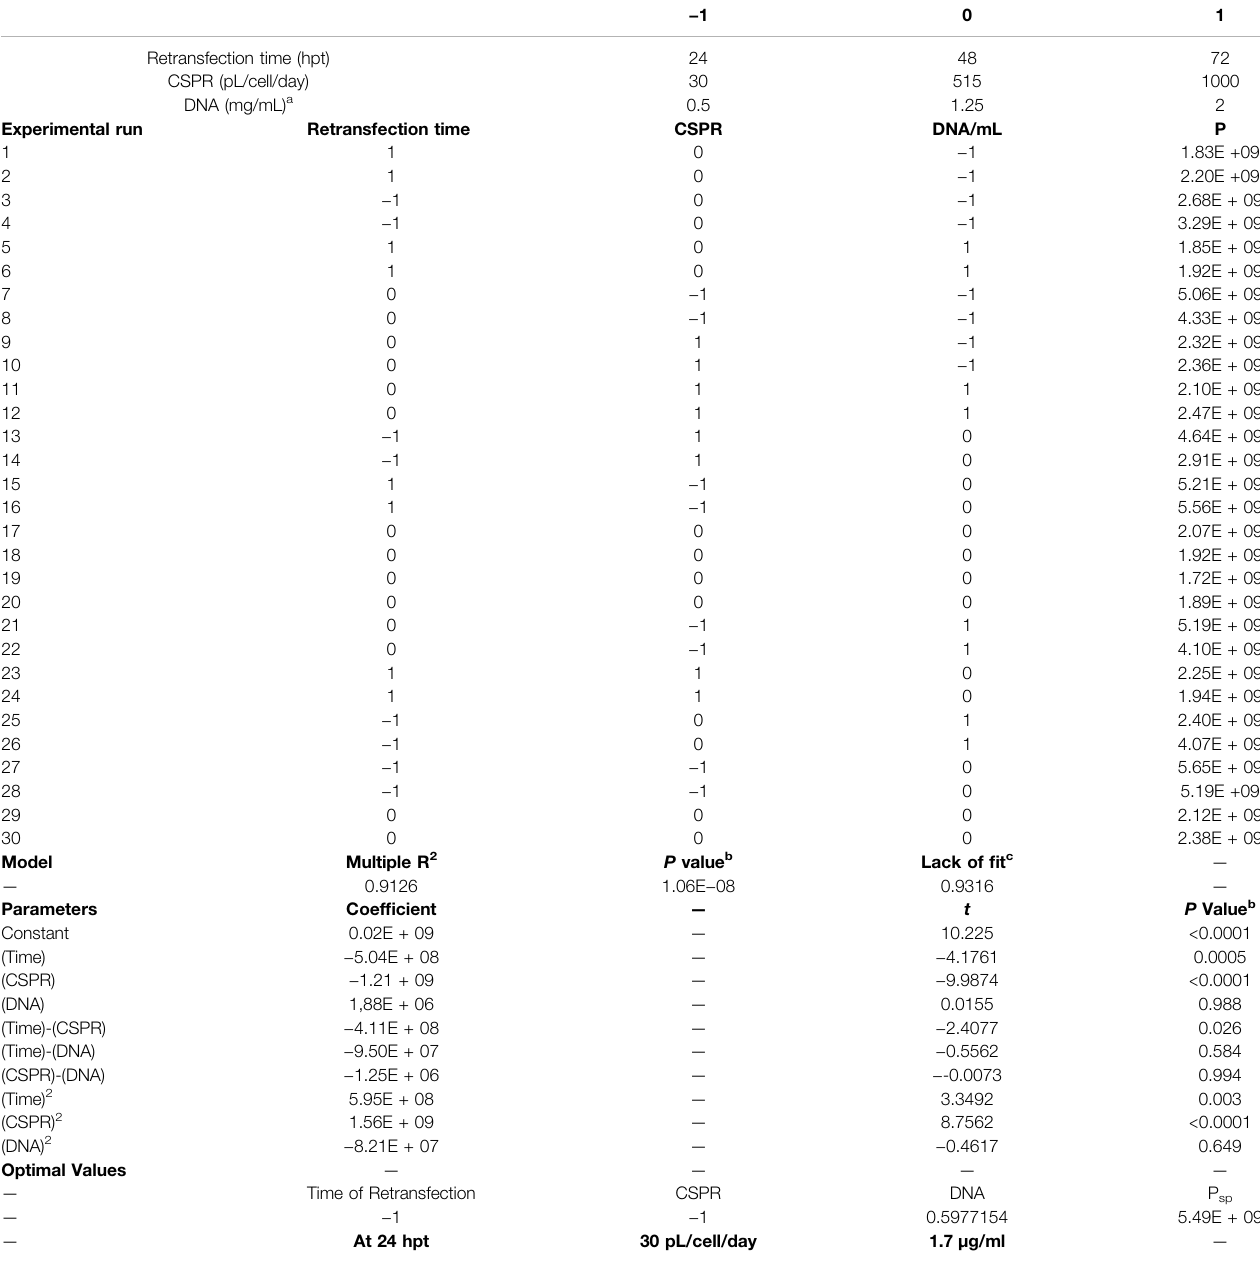
TABLE 1 | Box-Behnken design, results and ANOVA analyses for optimization of the extended gene expression (EGE) protocol for VLP production.